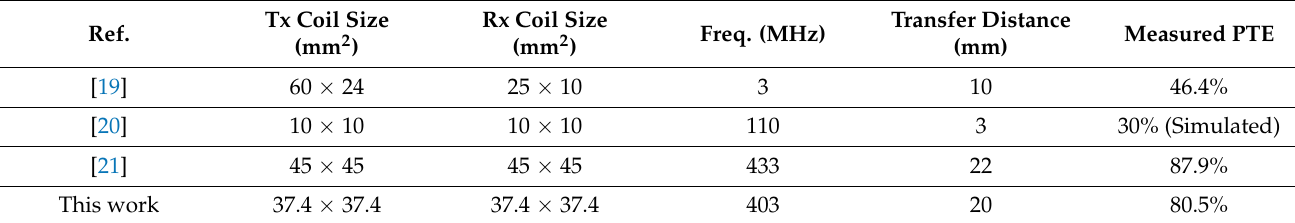
Table 4. The comparison between this proposed split-ring loop and the conventional rectangular PSC.